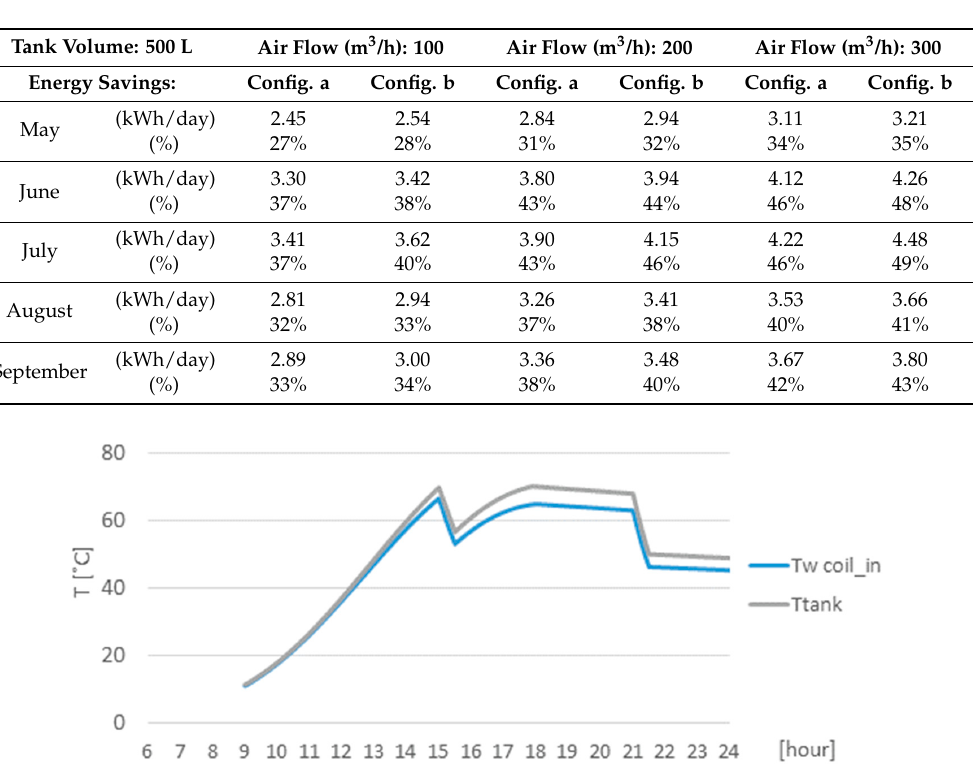
Table 7. Energy savings achievable during typical summer days through both configurations for a water tank of 500 L.